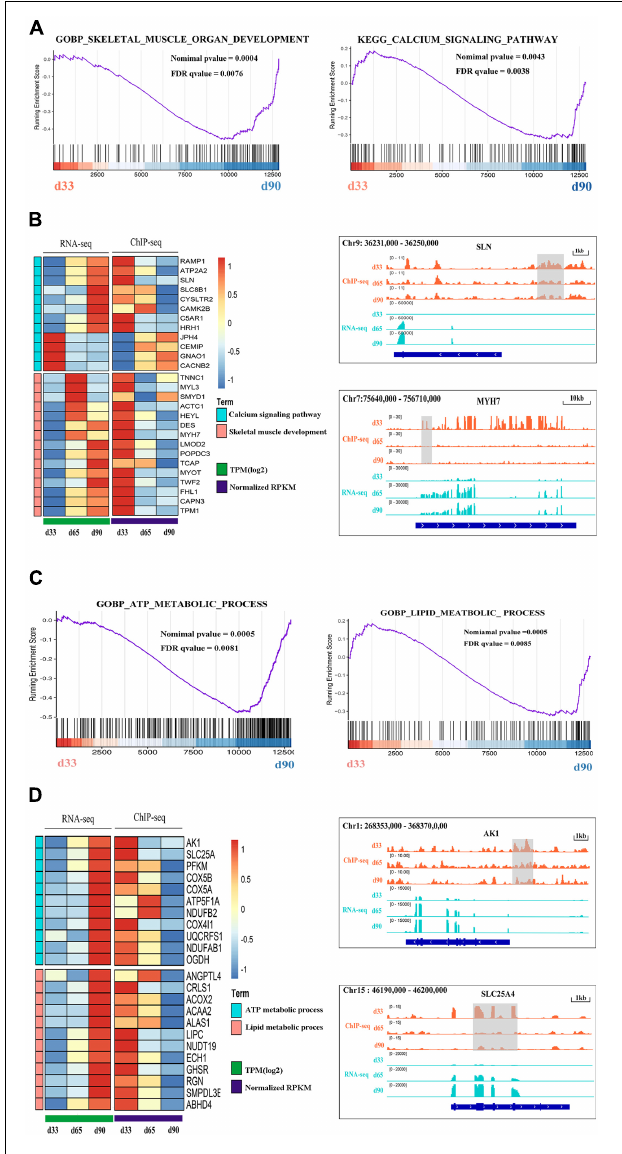
FIGURE 6 | The regulation of H3K27me3 during embryonic muscle development. (A) GSEA plot of genes involved in the skeletal organ muscle development and calcium signaling pathway on d33 and d90. (B) The gene expression heatmap of HDEGs (left) in the skeletal organ muscle development and calcium signaling pathway. Genome browser tracks (right) showing the H3K27me3 ChIP-seq (orange) and RNA-seq (light blue) data at SLN and MYH7 loci during embryonic muscle development. H3K27me3 peak region was colored in gray. (C) GSEA plot of genes involved in the process of ATP metabolic and lipid metabolic on d33 and d90. (D) The gene expression heatmap of HDEGs (left) in the process of ATP metabolic and lipid metabolic. Genome browser tracks (right) showing the H3K27me3 ChIP-seq (orange) and RNA-seq (light blue) data at AK1 and SLC25A4 loci during embryonic muscle development. H3K27me3 peak region was colored in